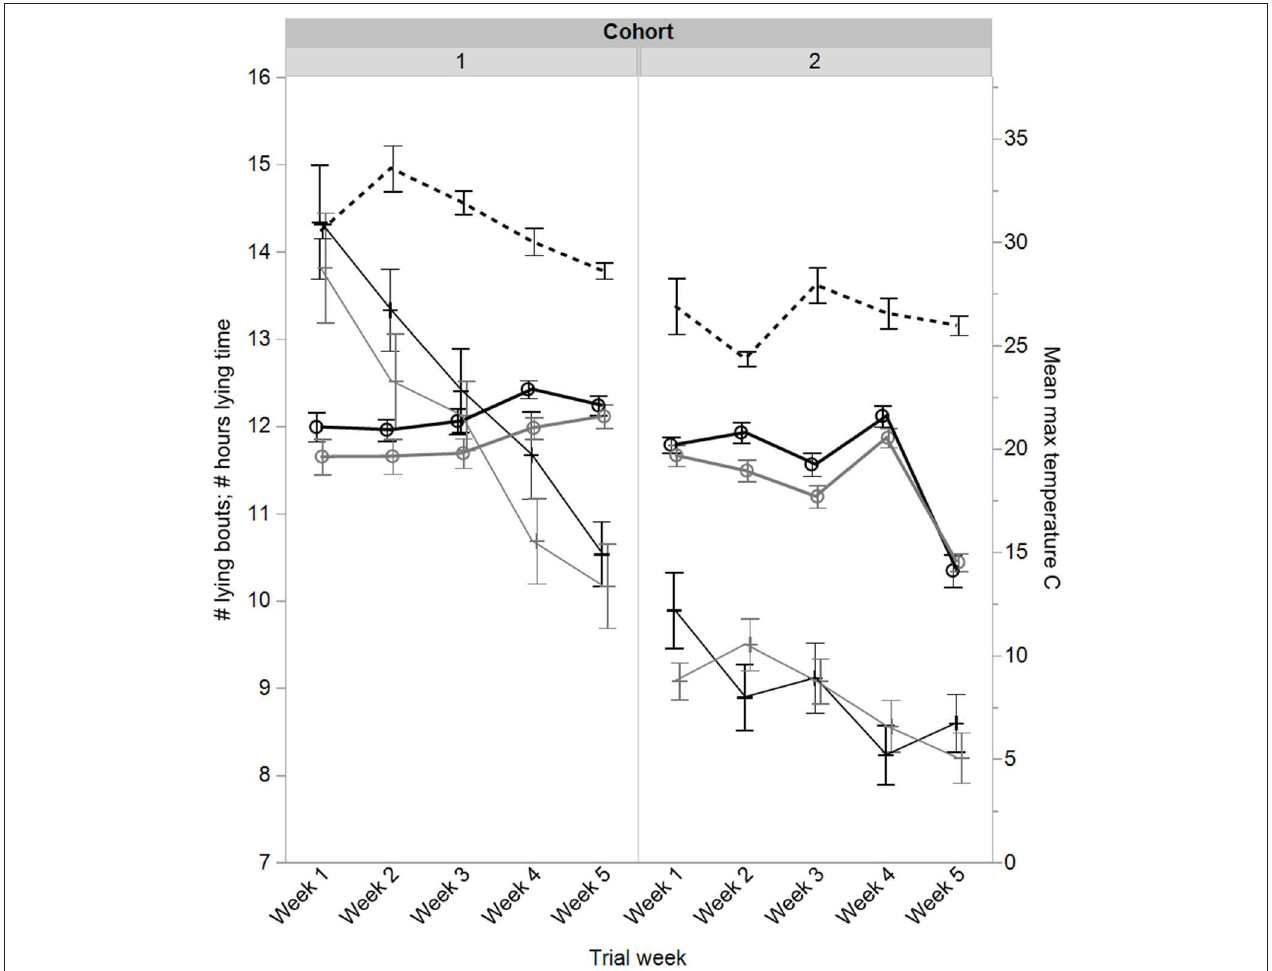
FIGURE 7 | Mean ± SEM daily lying time (hours) and number of daily lying bouts of cattle in the electric tape and virtual fence groups across the weeks of the trial for two cohorts. Mean ± SEM maximum temperatures ( ◦ C) are indicated for each trial week. The fences were set at the beginning of week 2. Raw data are presented.